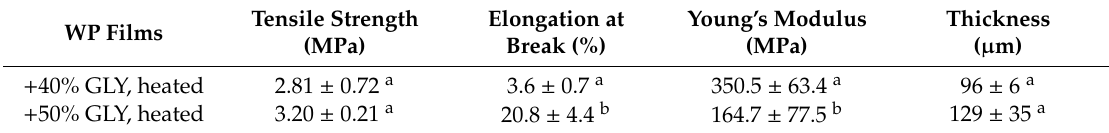
Table 3. Mechanical properties of whey protein (WP) films obtained at pH 7.